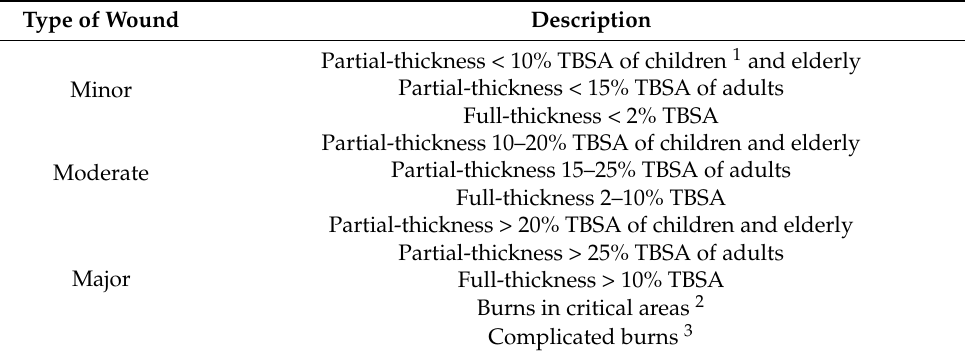
Table 1. Classification of burn wounds based on the American Burn Association’s Grading